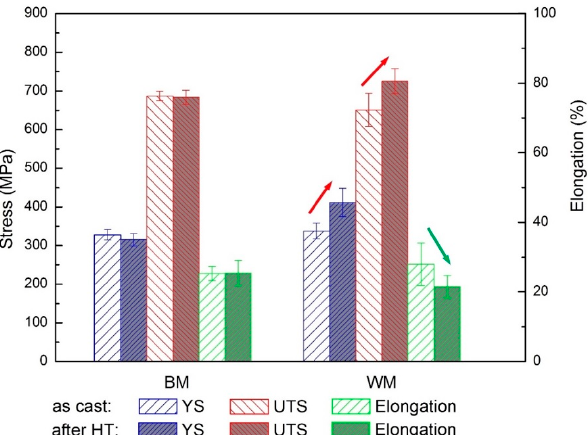
Figure 10. Effects of heat treatment on mechanical properties of as-cast BM and as-deposited WM. Each data point represents the average of samples from three different welding parameters, corresponding to the three-wall samples that were produced.